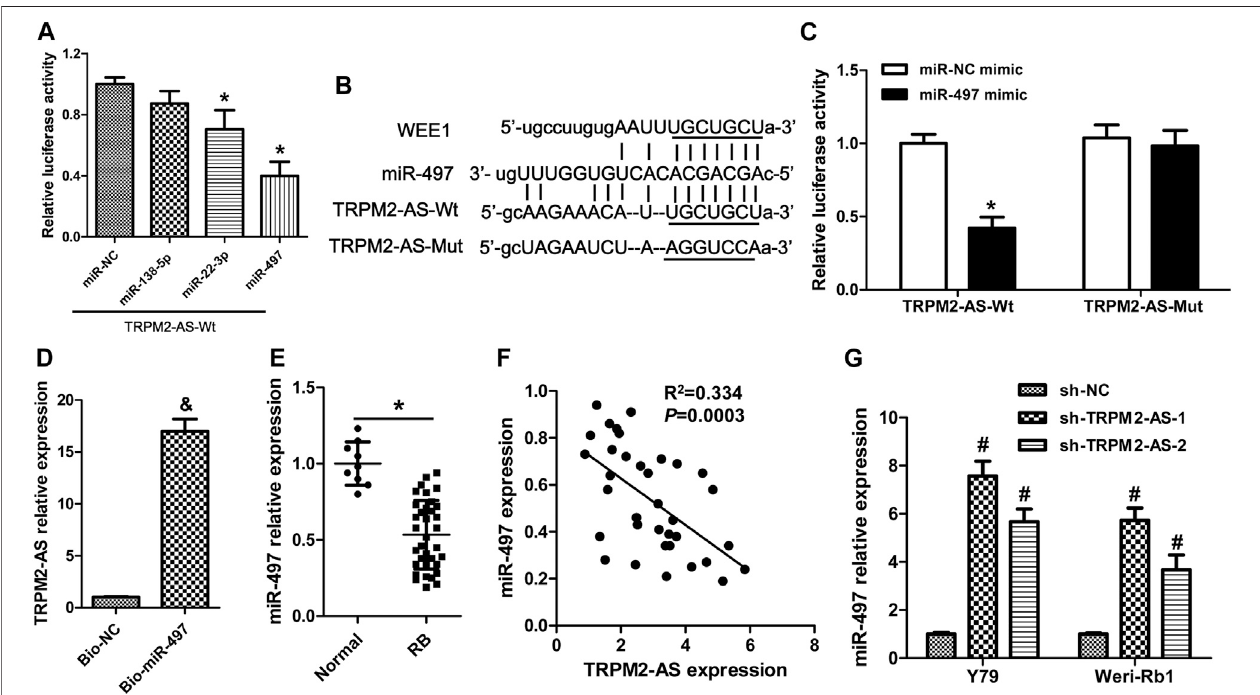
FIGURE 3 | TRPM2-AS directly binds to miR-497. (A) Relative luciferase activity from Y79 cells cotransfected with the TRPM2-AS reporter plasmid and three candidate miRNAs. (B) The binding sequences between TRPM2-AS/WEE1 and miR-497. (C) The relative luciferase activity of Y79 cells cotransfected with pGL3- TRPM2-AS wild/mutant type and miR-497/miR-NC mimic. (D) Weri-Rb1 cells were transfected withbiotin-labeled(Bio)-miR-497 or its control (Bio-NC); the enrichment of TRPM2-AS in the biotinylated RNA complex was analyzed. (E) miR-497 expression in human tissues was detected by real-time PCR. (F) Correlation between TRPM2-ASandmiR-497inhumanRBtissues.( G) miR-497expressionwasincreasedinRBcellsafterdownregulationofTRPM2-AS.* p < 0.05vs.themiR-NCmimicor normal group; & p < 0.05 vs. the Bio-NC group; # p < 0.05 vs. the sh-NC group.